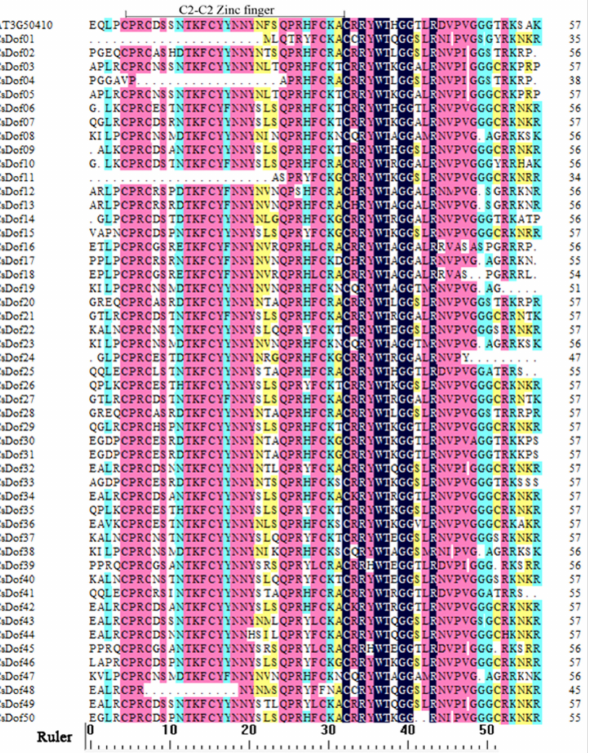
Figure 1. Multiple sequence alignment of the Dof domain in C. songorica and Arabidopsis .